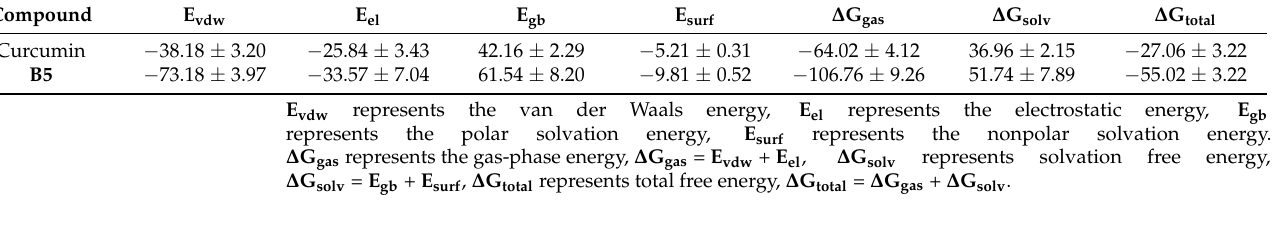
Table 2. Binding free energy of AKT with curcumin or B5 calculated by MM-GBSA. Predicted ∆ G